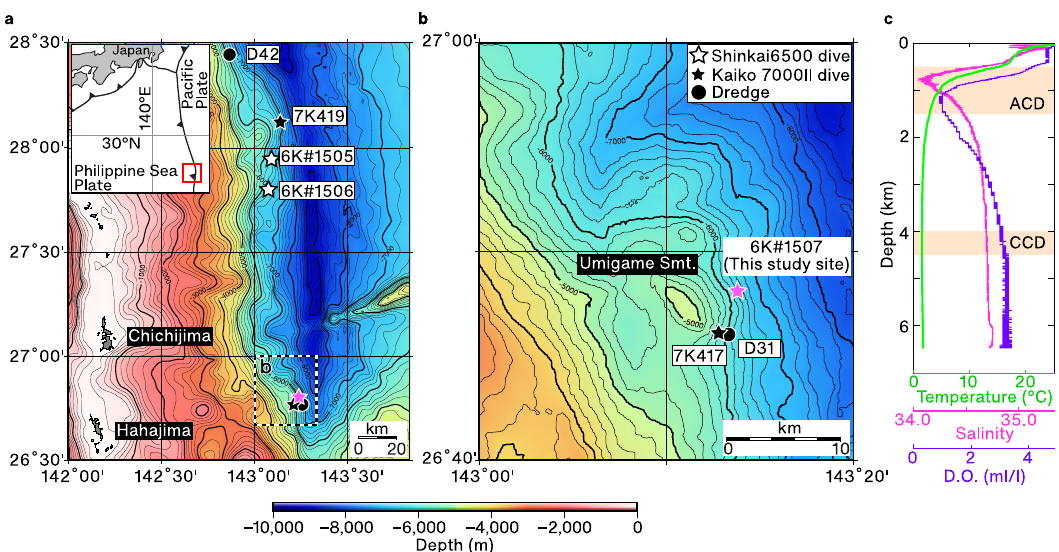
Fig. 1 Location of the Shinkai dive #1507. a Bathymetric map of Izu – Ogasawara trench, with inset map showing the location of Japan and of the study area (red rectangle). The sampling location of serpentinized peridotite (6K#1507) is shown by a pink star, along with previous locations where peridotite or gabbro were recovered. b Enlarged bathymetric map of the area depicted by the black-and-white rectangle in Fig. 1a, around the Umigame seamount located in the southern Izu – Ogasawara Trench. Maps in a and b were drawn using Generic Mapping Tools 5.4.5 92 with ETOPO1_Bed_g_gmt4.grd 93, 94 ( a ) and grid data from the KR08-07 and KH07-02 cruises ( b ). c Depth pro fi les of seawater temperature, salinity, and dissolved oxygen (D.O.) during the DSV Shinkai 6500 dive #1507 (13 July 2017). The dive and sampling were conducted at ~6400 mbsl, which is deeper than both the carbonate (calcite)